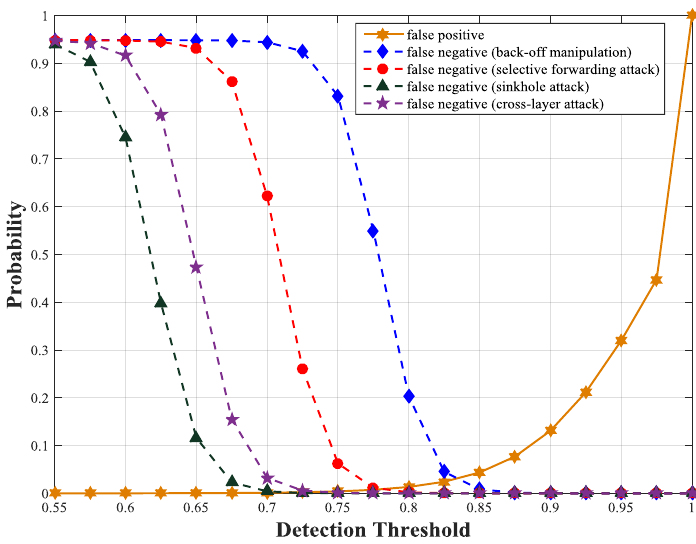
Figure 6. False positive and negative probabilities with different thresholds using formula calculation.